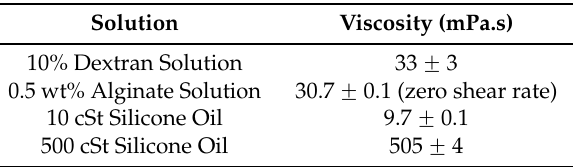
Table 2. Viscosity of various solutions used in the fabrication of modified alginate capsules. Data was measured at 25 ˝